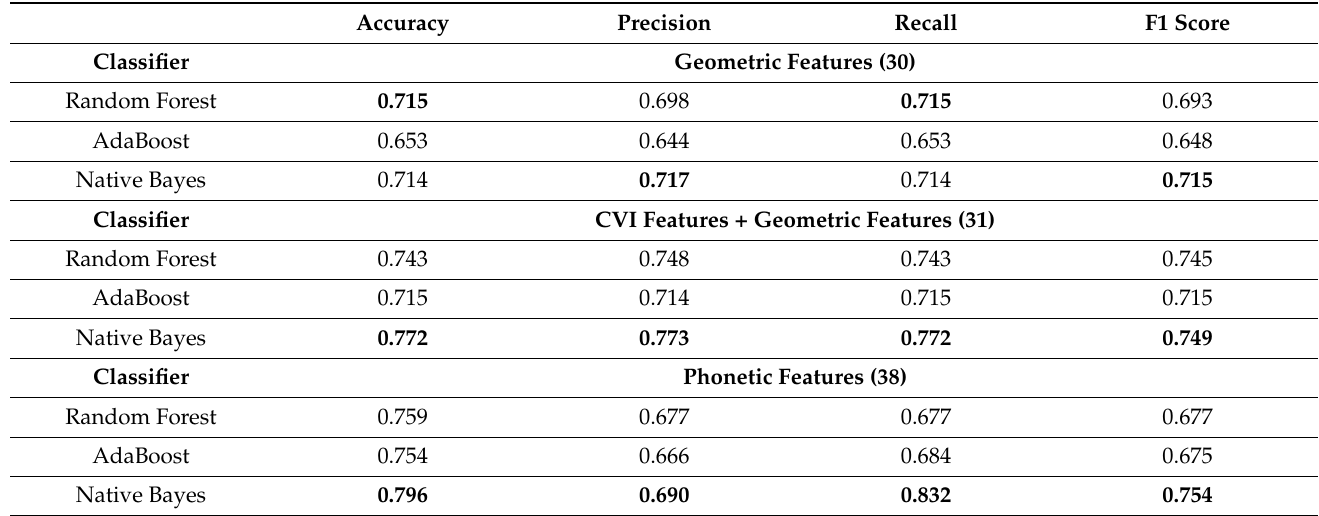
Table 4. Algorithm performance based on three different types of